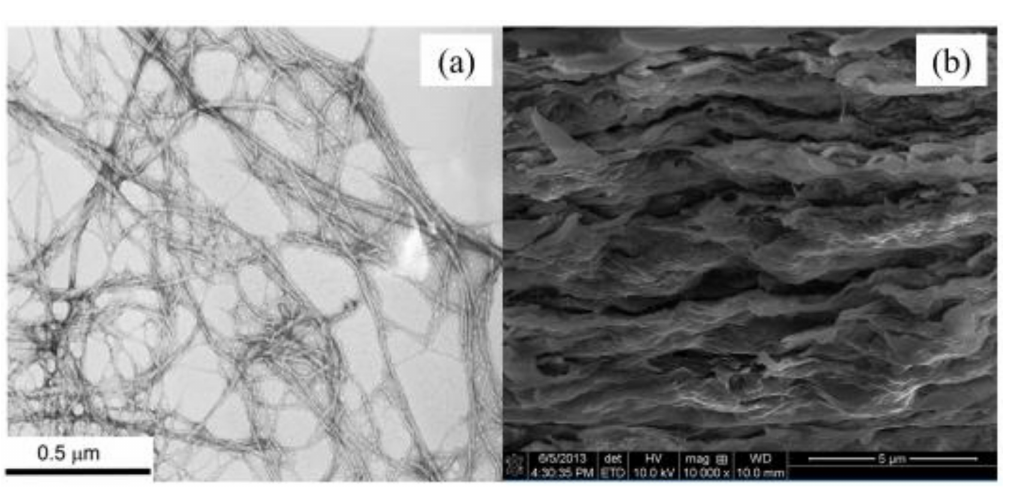
Figure 2. ( a ) Transmission electron microscopy (TEM) micrograph of the pure CNF and ( b ) scanning electron microscopy (SEM) micrograph of the 90CNF / 10NC composite